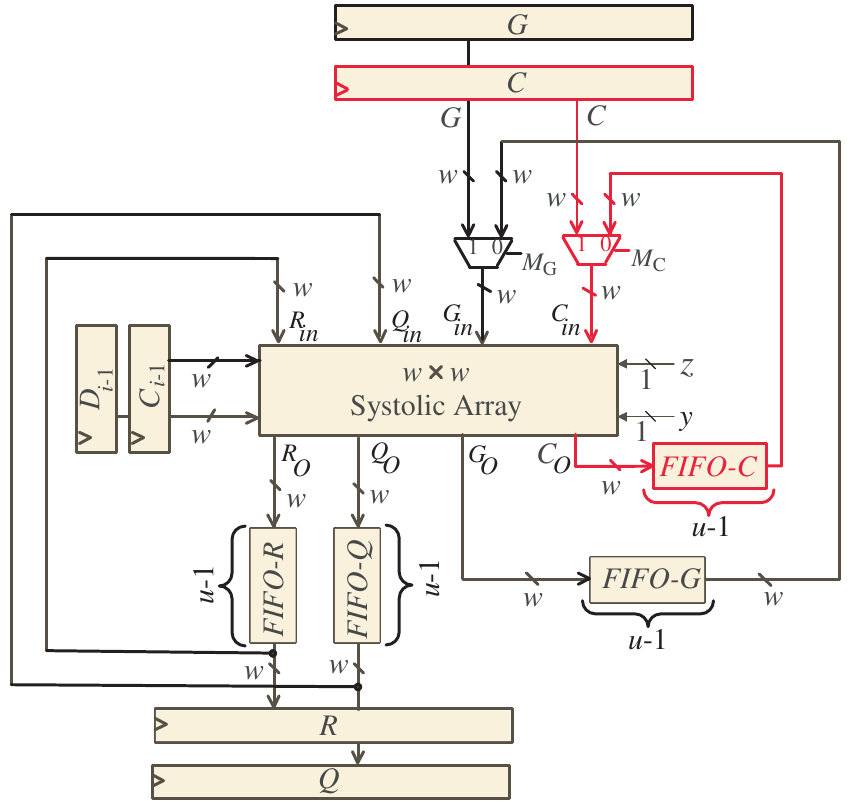
Figure 5. Word-based two-dimensional SISO systolic processor. The Word-based two-dimensional SISO systolic processor consists of w × w systolic array block as well as input/output registers and FIFO buffers in addition to two 2-input MUXes for selecting between the inputs of C and G and their intermediate values. The resulting intermediate words of R , Q , and C and the words of G are pipelined